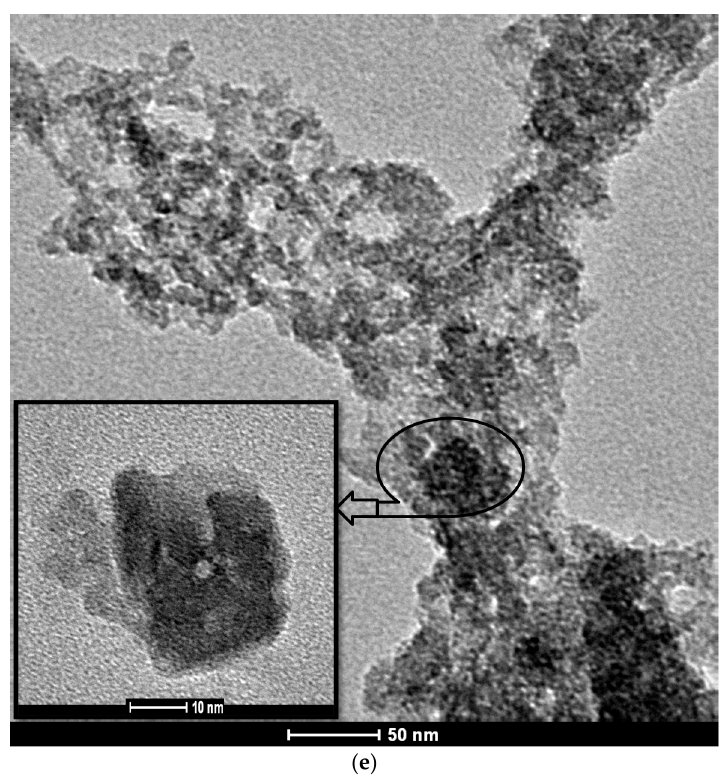
Figure 2. ( a ) SEM image of ZrSiA as ‐ synthesized sample with its included TEM image; ( b ) SEM image of ZrAlA as ‐ synthesized sample with its included high magnification image; ( c ) TEM images of the calcined SiAlC sample; ( d ) TEM image of SiAlA after modification of the solid with extraction procedure (SiAlE); ( e ) TEM image of SiAlA after modification of the solid with reflux procedure (SiAlR).